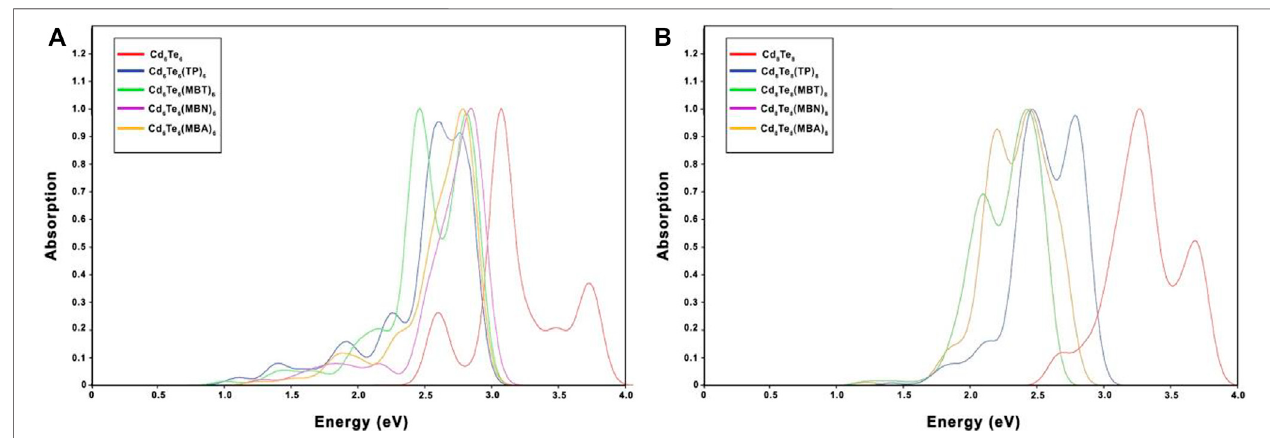
FIGURE 10 | Absorption spectra of bare and capped Cd 6 Te 6 (A) and Cd 8 Te 8 (B) , calculated with TDB3LYP/Lanl2DZ approach.